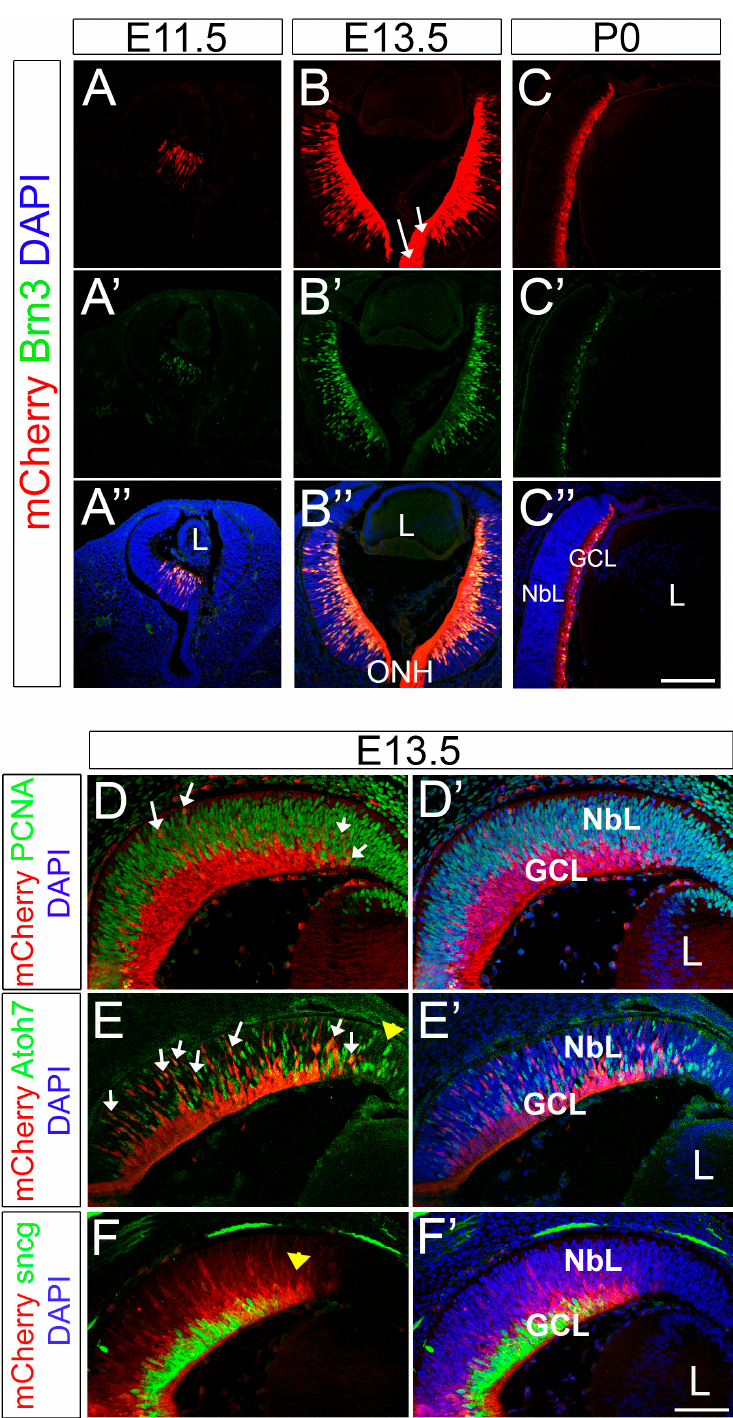
Figure 3. Brn3b-mCherry expression during early retinal development. ( A – C” ) Co-localization experiments of mCherry and pan-Brn3 antibody at E11.5 (A-A”), E13.5 ( B – B” ) and P0 ( C–C” ). White arrows in B indicate mCherry + RGC axons. D–F’ ) E13.5 retina stainings. ( D , D’ ) mCherry (red) and PCNA (green) co-localization. White arrows: PCNA + mCherry + cells. ( E , E’ ) mCherry (red) and Atoh7 (green) co-localization. White arrows: mCherry + Atoh7 + cells. Yellow arrowhead indicates the leading edge of neurogenesis. ( F , F’ ) mCherry (red) and γ -synuclein (green) colocalization. Yellow arrowhead indicates the leading edge of neurogenesis. L: Lens. NbL: Neuroblastic Layer. GCL: Ganglion Cell layer. Scale bars: 200 microns A–C”, 100 microns